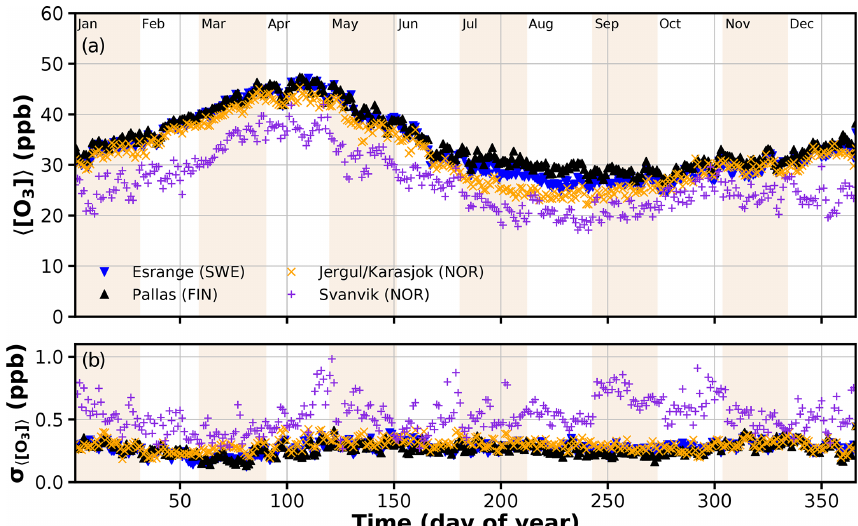
Figure 2. Daily mean ozone climatologies (upper panel) and standard error (lower panel) over the day of the year. All stations located in northern Fennoscandia with data records exceeding 10years are displayed. The data taken at Jergul and Karasjok have been